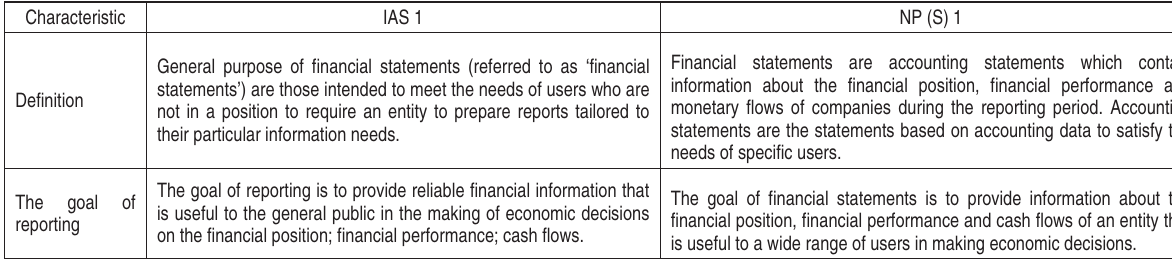
Table 1. Regulatory requirements to financial reporting according to IAS 1 and NP (S)